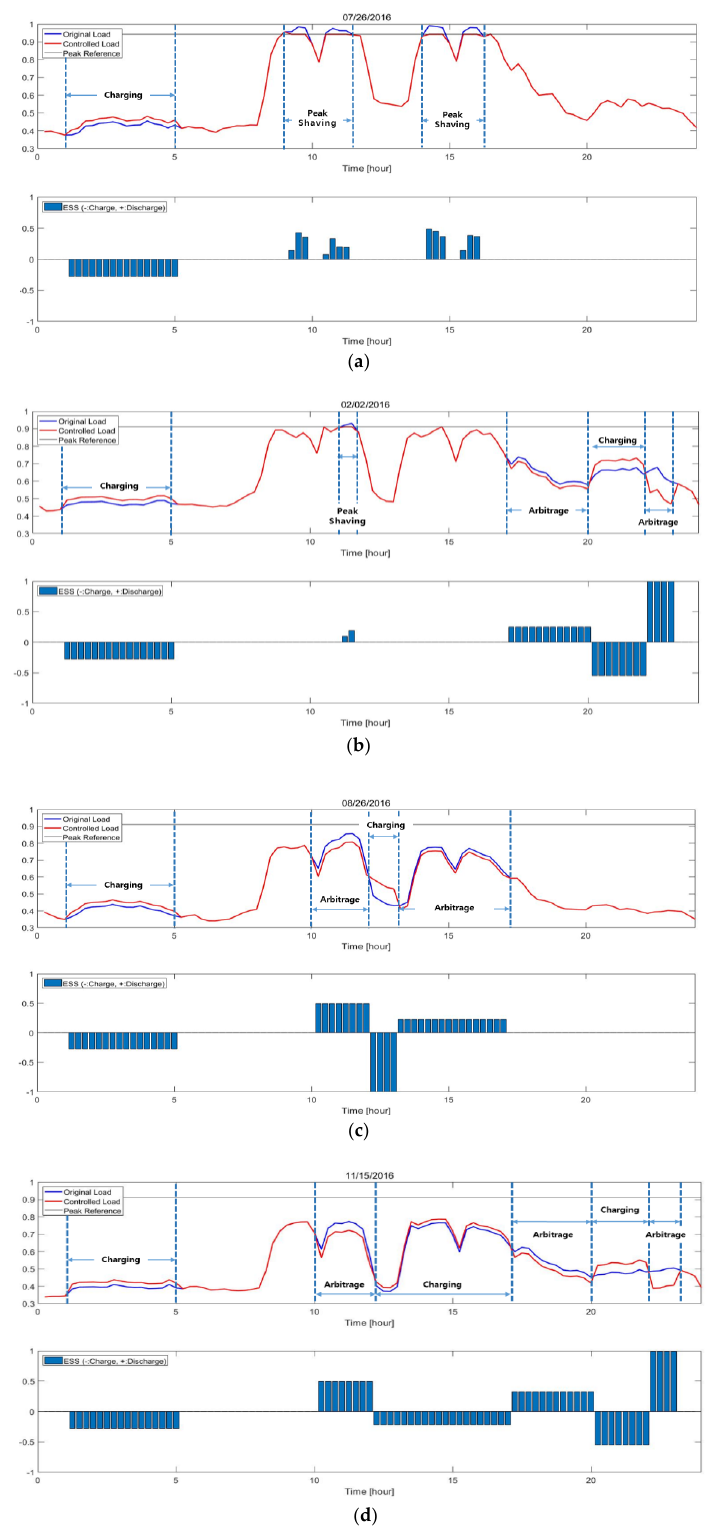
Figure 2. Examples of Daily ESS operations: ( a ) only peak shaving, ( b ) combined operation of peak shaving and arbitrage, ( c ) only arbitrage with 2-cycle, and ( d ) only arbitrage with 3-cycle.